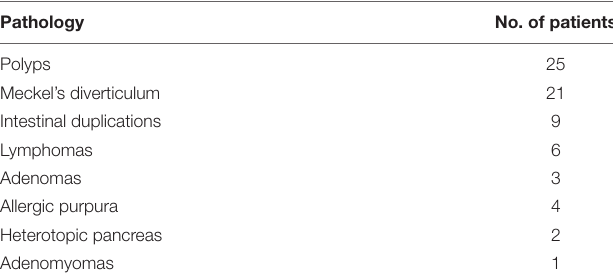
TABLE 3 | Pathology of patients with intussusceptions in the primary